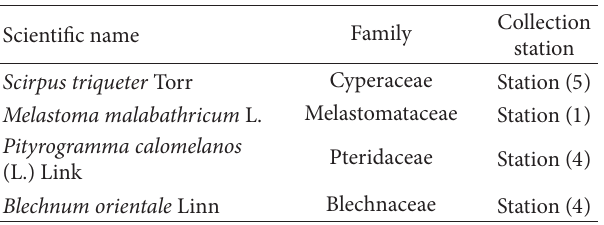
Table 2: The scientific name, family, and collection station of the